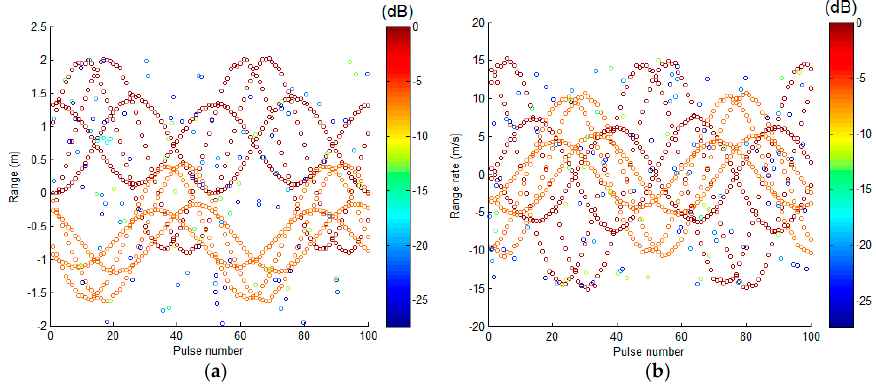
Figure 5. 1D range and range rate estimates: ( a ) range estimate; ( b ) range rate estimate.